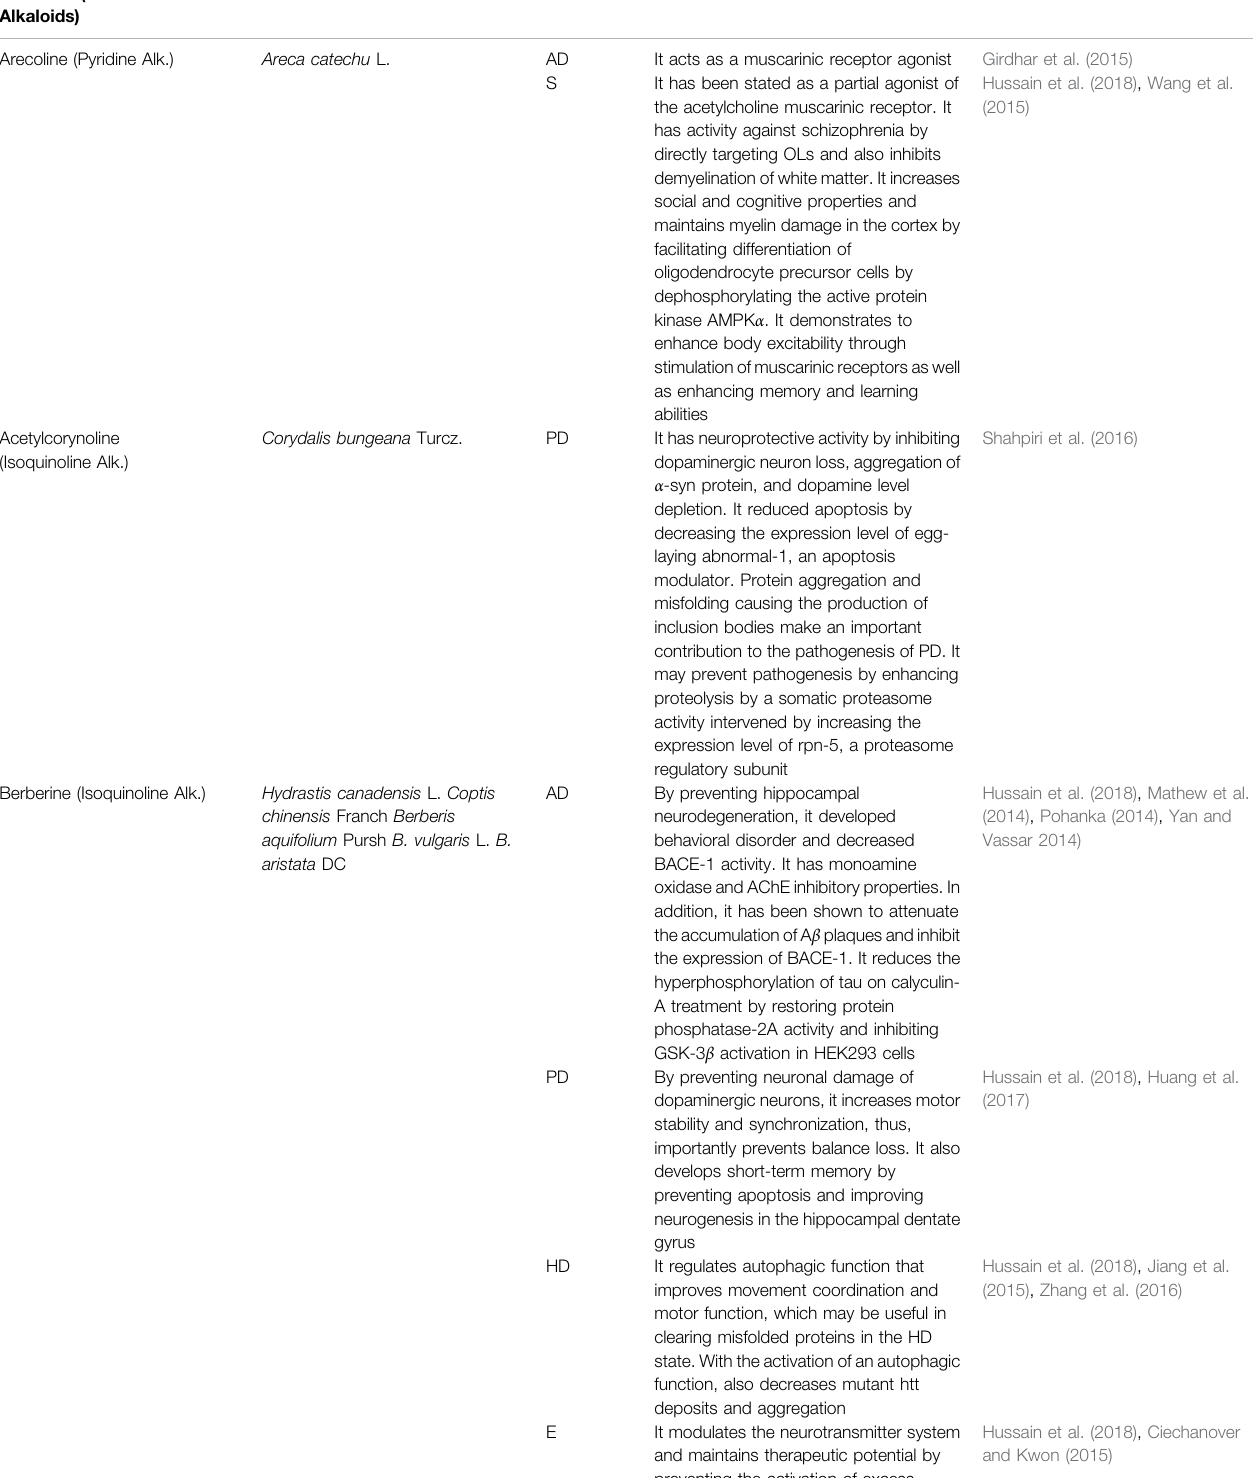
TABLE 1 | Alkaloids, their sources, target neurodegenerative diseases and their mechanism of